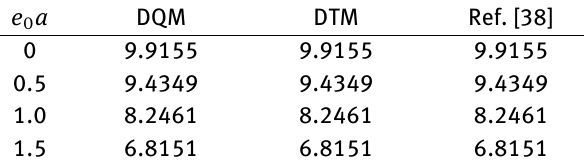
Convergence of DTM ( L / d = 10, e 0 a = 1)